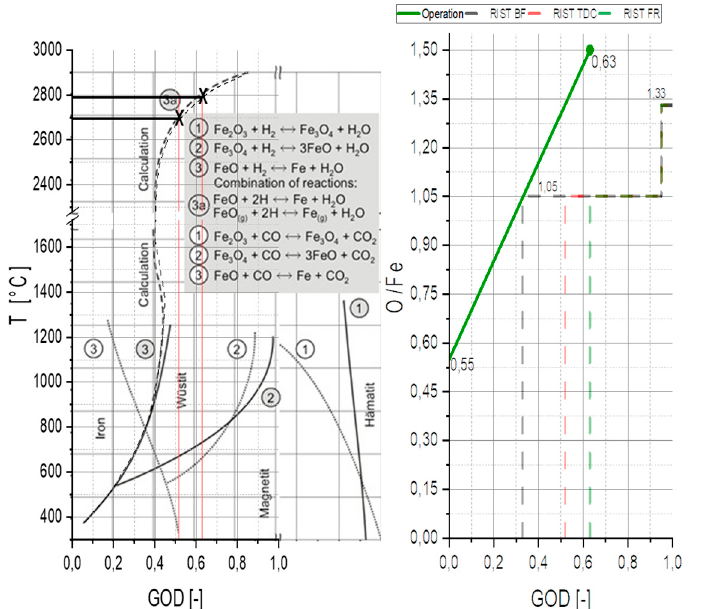
Figure 12. Stability fields of iron oxides in the Baur Glaessner (BG) Diagram (left) [4] combined with the operational points of trial B50/C1.56 shown in the RIST diagram (right), Operational field (OF) for Blast furnace (BF, grey dashed), OF for thermal decomposition (TDC, red dashed), and OF for full reduction (FR, green dashed) from hematite to metallic iron.